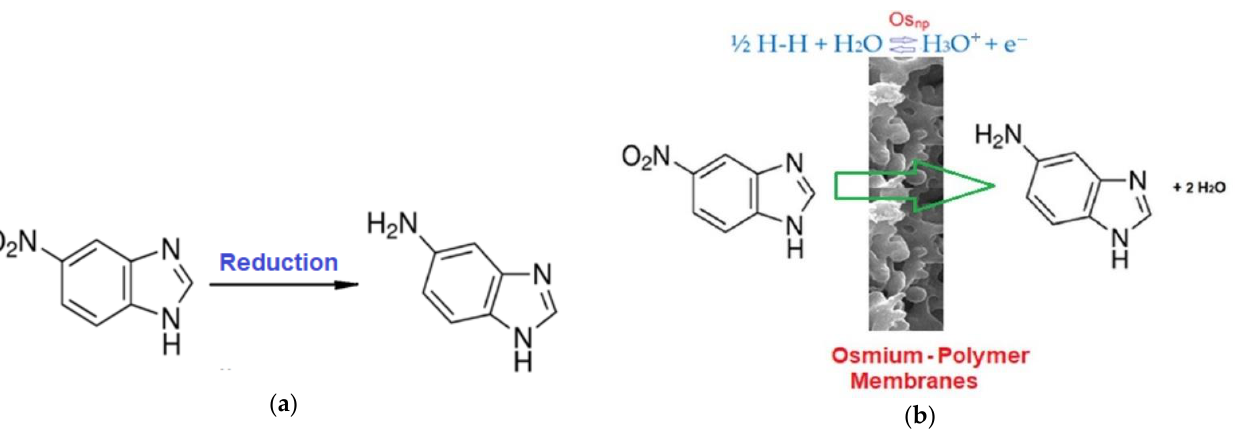
Figure 6. Reduction scheme of 5 – nitrobenzimidazole to 5 – aminobenzimidazole ( a ) and reduction scheme of 5 – nitrobenzimidazole to 5 – aminobenzimidazole on osmium – polymer membranes (Os – P) ( b ).